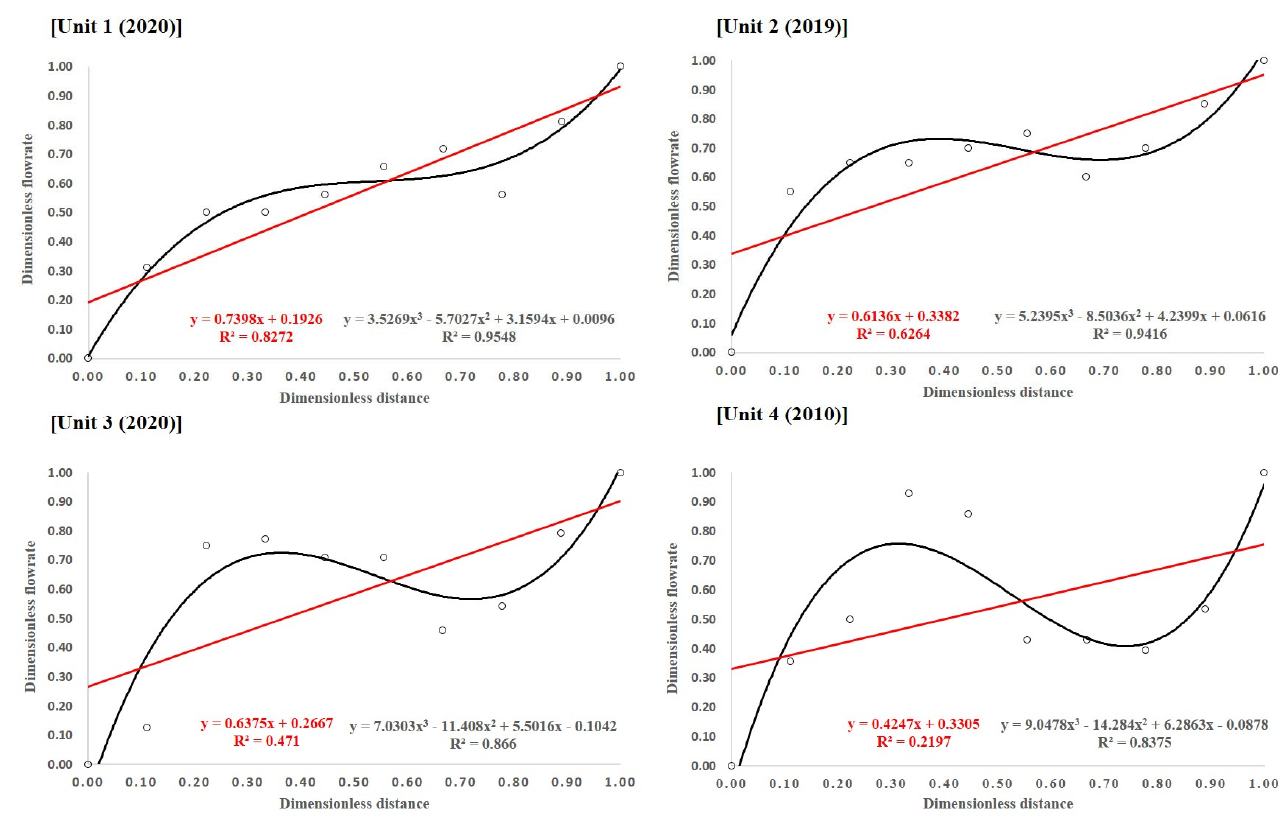
Figure 6. Statistical analysis results.